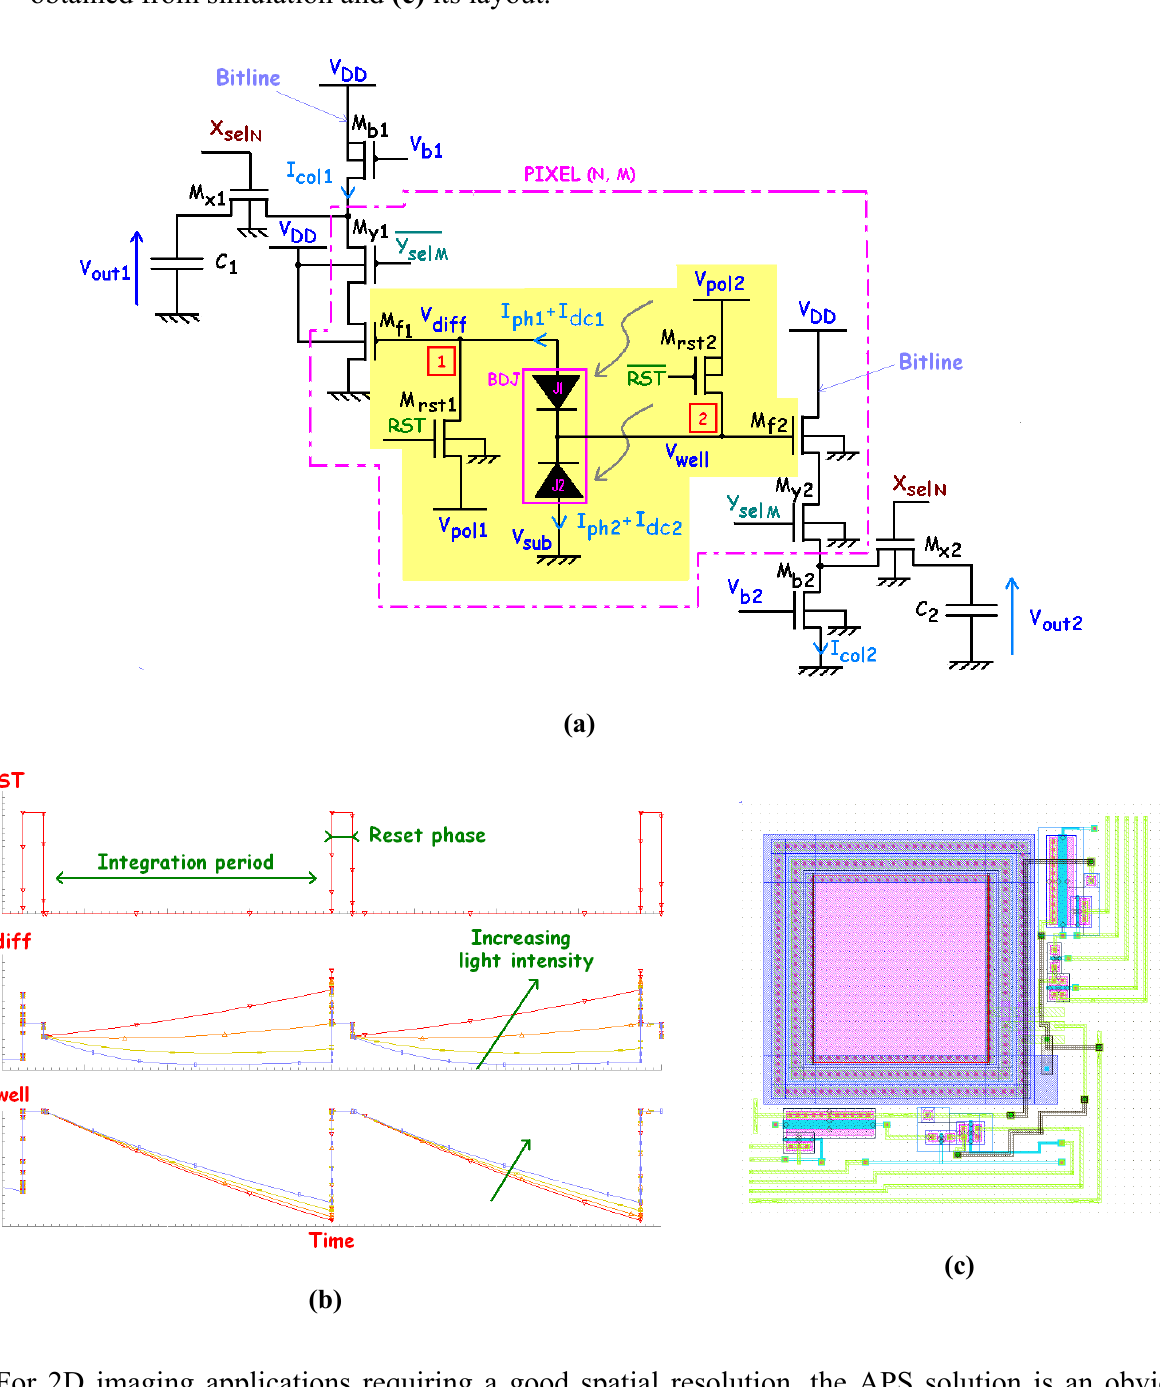
Figure 22. (a) CMOS BDJ APS architecture, (b) its corresponding timing diagram obtained from simulation and (c) its